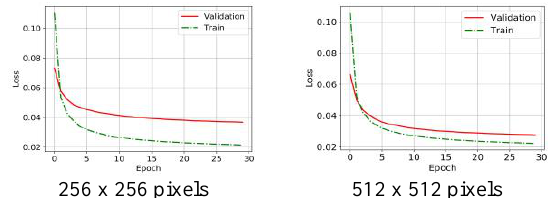
Figure 4. Loss function for SegNet using resolutions of 256 x 256 and 512 x 512 pixels.